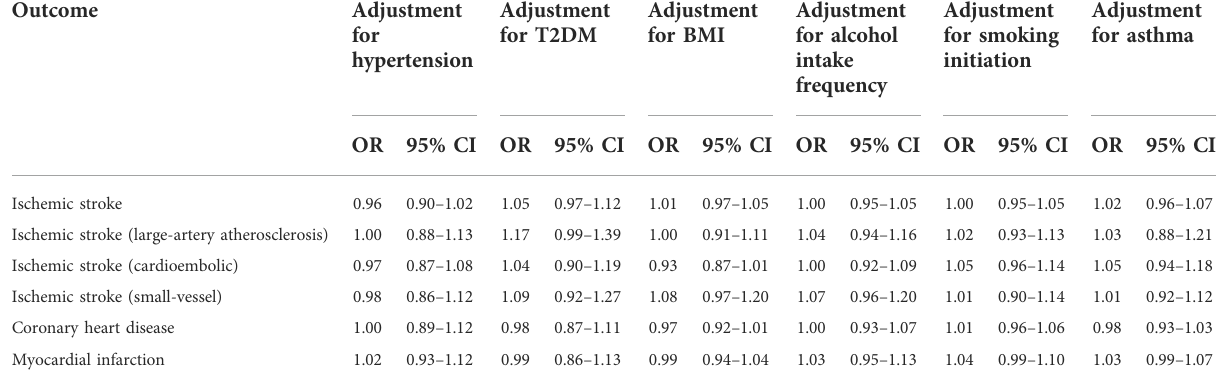
TABLE 2 Multivariable MR for assessing the association of atopic dermatitis with ischemic stroke and coronary heart disease. Outcome Adjustment